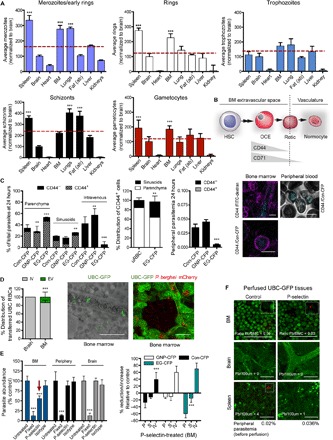
Parasite homing and extravascular BM localization during mouse infection.(A) Synchronous infections of mice with mCherryHsp70-FLucef1α merozoites, rings, trophozoites, schizonts, or gametocytes. Data show that merozoites, rings, and gametocytes are significantly enriched in BM and spleen (red arrows, ***P < 0.001) compared to mean across all organs (dashed line). Data are expressed relative to parasite numbers quantified in the brain (normalized to 100) and correspond to intravascular and extravascular compartments in all organs. (B) Representative diagram of hematopoietic development. Hematopoietic stem cells (HSCs) undergo a series of developmental steps until formation of the final nucleated stage termed orthochromatic erythroblast (OCE), which upon enucleation gives rise to reticulocytes (Retic). Reticulocytes intravasate into circulation and rapidly mature to terminal normocytes. Extravascular RBC precursor cells are marked by CD44, whereas CD71 is lost shortly after intravastion. (C) Presence of stage-specific reporter parasites in CD44+ RBCs following injection of merozoites. At 24 hpi, EG-CFP parasites, but not GNP-CFP and Con-CFP parasites, are largely confined to parenchyma and sinusoids where most are present in CD44+ RBCs (left panel), reflecting distribution of CD44+ RBCs (mid left panel). No parasites are detected in CD44+ cells in peripheral blood (mid right panel). Representative images of CD44+ cells in a BM section (magenta) are shown, upon injection of fluorescein isothiocyanate (FITC)–dextran (cyan) to mark vasculature (top panel). Bottom image: Close-up of an infected CD44+ RBC in BM. (D) Presence of uninfected UBC-GFP RBCs in the BM extravascular niche. UBC-GFP RBCs were obtained from transgenic donor mice and injected into naïve, uninfected recipient mice and quantified in BM. A small proportion of RBCs accumulates in BM extravasculature but not in the brain extravascular niche (left panel). Representative image is shown (left) and a control with mCherryHsp70-FLucef1α
P. berghei parasites (right). (E) Inhibition of parasite extravasation using receptor antibodies. Mice were pretreated for 24 to 48 hours with P-selectin antibodies before injection of mCherryHsp70-FLucef1α merozoites and compared to untreated and nonviable (4% paraformaldehyde-fixed) control parasites (left panel). Parasite abundance in BM but not in brain or peripheral circulation is reduced upon P-selectin pretreatment compared to controls. Injection of merozoites from stage-specific reporter parasites upon P-selectin pretreatment reveals greatest reduction in BM parenchyma with EG-CFP and Con-CFP parasites, whereas intravascular localization is increased (right panel). Error bars represent SEs from five separate experiments in three mice per condition. (F) Quantification of peripheral parasitemia upon treatment with receptor antibodies. UBC-GFP mice were pretreated for 24 to 48 hours with P-selectin before injection of mCherryHsp70-FLucef1α merozoites (right panel) and compared to untreated control parasites (left panel). Peripheral parasitemia and tissue burden were quantified before and after cardiac perfusion to remove circulating parasites—leaving only those in the extravascular spaces. Extravascular parasite load decreases significantly in BM and spleen compared to control animals, whereas peripheral parasitemia (obtained before perfusion) increases. P values are shown as **P < 0.05 and ***P < 0.005. All error bars represent SDs of the mean.